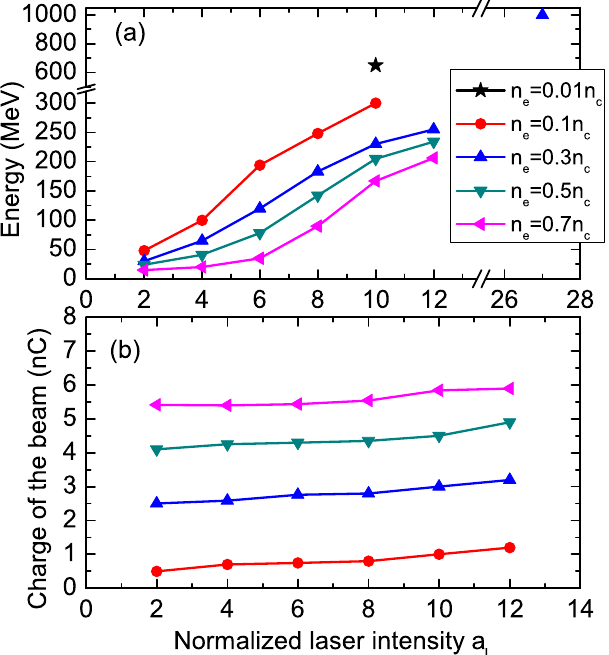
FIG. 6. Dependence of (a) energy and (b) charge of the electron beam on the laser intensity and plasma density. In all cases, the laser spot radius b ¼ 10 λ , duration τ ¼ 5 T 0 , and the distance between the two laser pulses is 25 λ